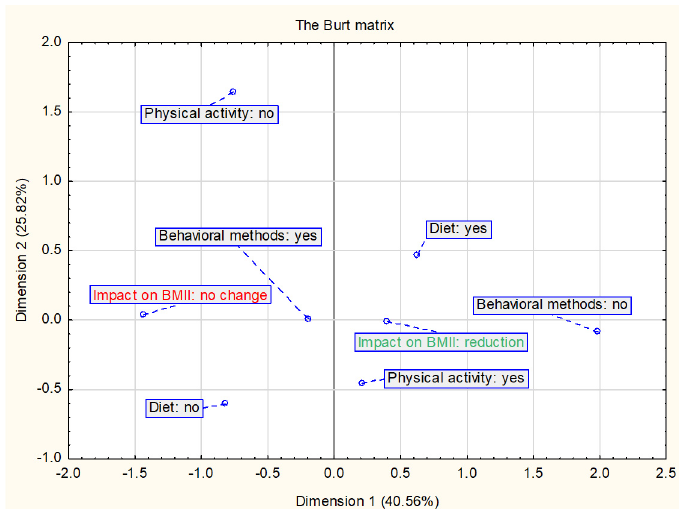
Figure 2. Presentation of the correspondence analysis results defining the relationship between the nutritional and physical activity interventions and changes in BMI and/or BMI z-score ( n = 23).